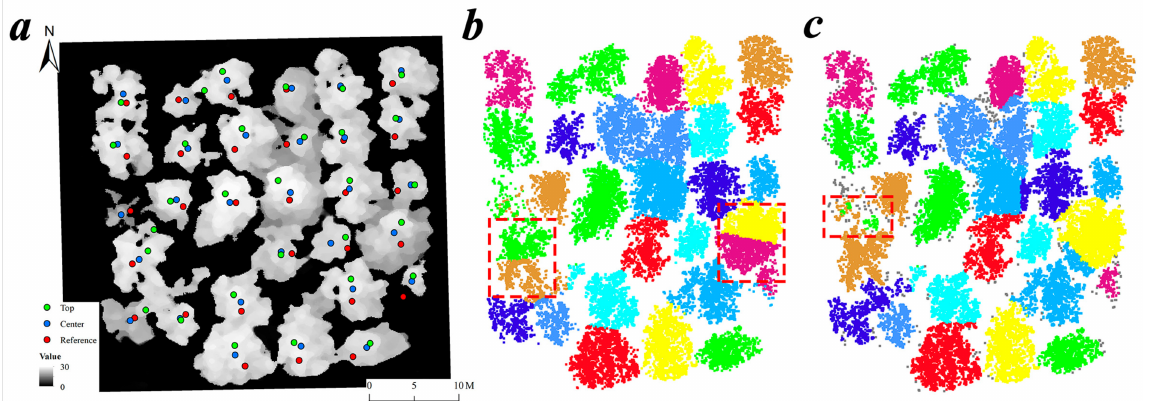
Figure 11. Errors for the seed points based ITS methods in the sample plot Y16-2. ( a ) The positions of the center seeds, top seeds and the RTK references of tree locations. ( b ) Errors for the Seeds + Kmeans method. The red rectangle is the segmentation error caused by iterative center seed points. ( c ) Errors for the Seeds + Dalpnote2016 method. The red rectangle is the segmentation error caused by wrong top seed